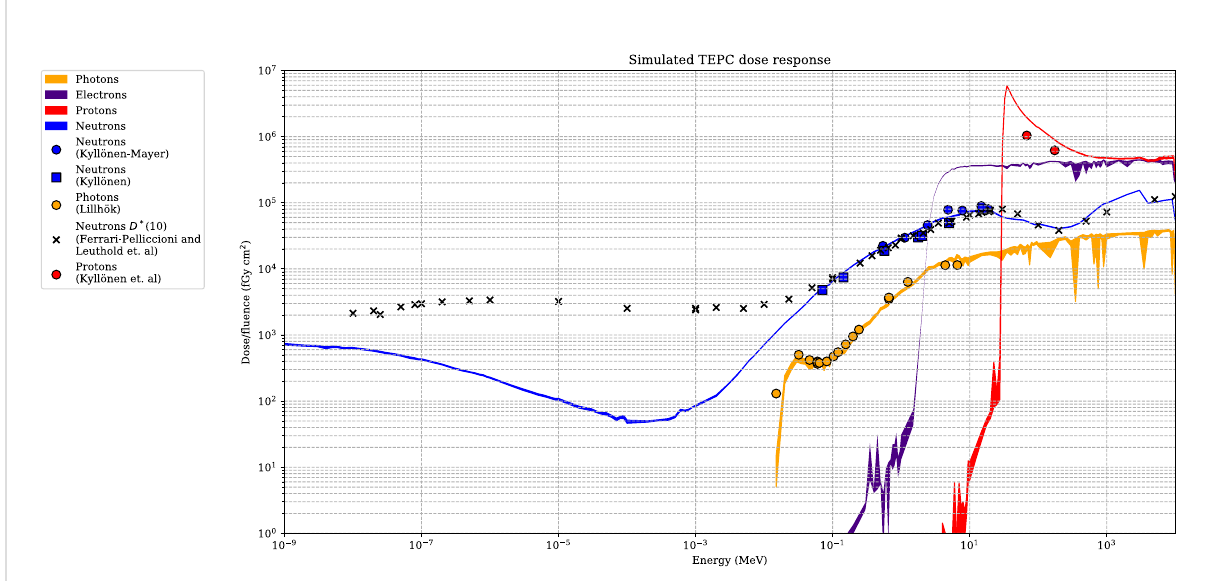
FIGURE 6 The dose-simulated response for the Sievert detectors, with associated uncertainties (k = 1) represented as colour bands. The simulated response is compared with experimental data from Kyllönen and Mayer (28), Kyllönen et al. (19), Lillhök (18), and Kyllönen et al. (21). Simulated conversion coef fi cients to ambient absorbed dose from Ferrari and Pelliccioni (29) and Leuthold et al. (30) are also included.